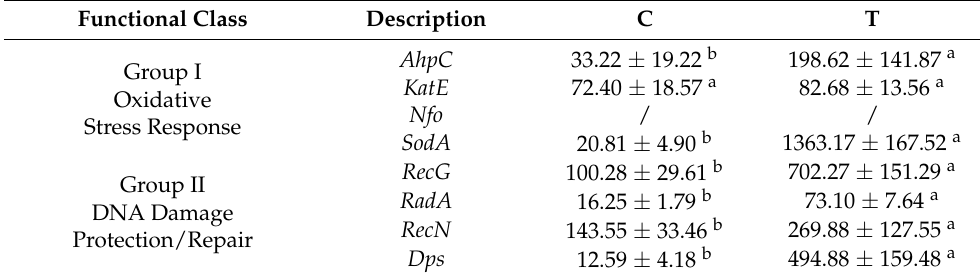
Table 1. The effect of HVEF treatment on relative expression of the target gene of A. johnsonii . Functional Class Description C T Group I Oxidative Stress Response